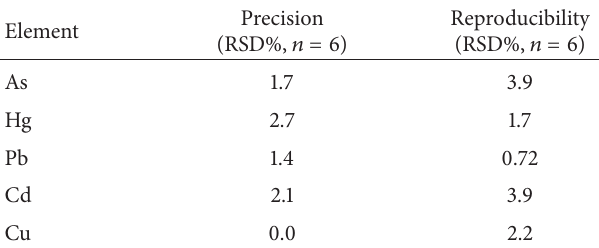
Table 4: The results of the accuracy of the method (𝑛 = 6)